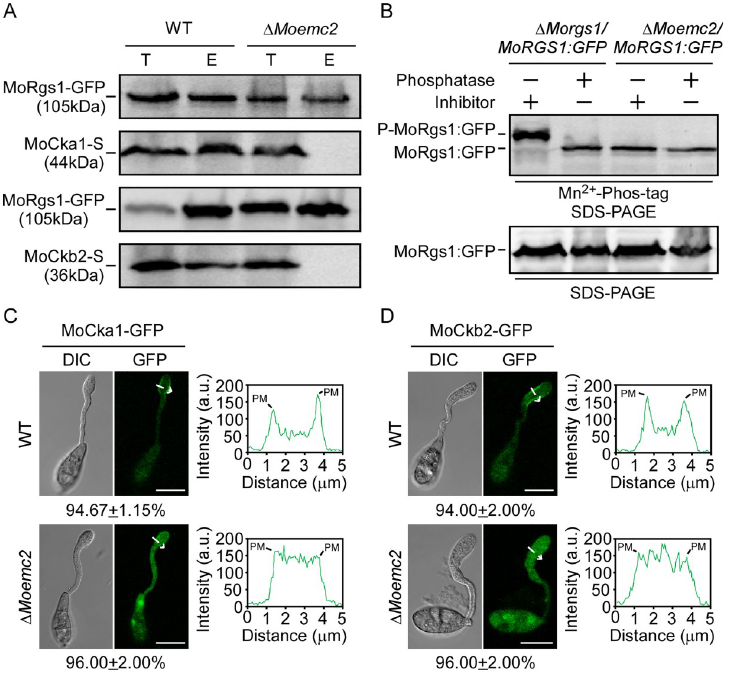
Fig 4. MoEmc2 is required for MoCk2 function and proper subcellular localization. (A) Co-IP assays for interactions between MoRgs1-GFP and MoCka1-S and MoCkb2-S in the wild type (WT) and mutant Δ Moemc2 strains. Total proteins were extracted and eluted from the anti-GFP agarose beads before being analyzed by Western blot with corresponding antibodies. T: Total protein E: Elution. (B) Phosphorylation analysis of MoRgs1 in the WT and Δ Moemc2 strains in vivo by Mn 2+ -Phos-tag gel electrophoresis. MoRgs1-GFP fusion proteins treated with phosphatase and phosphatase inhibitors were detected by the GFP antibody and shifted by Mn 2+ -Phos-tag SDS-PAGE and normal SDS-PAGE, respectively. (C and D) Fluorescence RFP labeled MoCka1 and MoCkb2 fusion constructs were introduced into the WT and Δ Moemc2 strains, respectively. Transformants were observed and photographed by LSM (Zeiss LSM710 laser scanning microscope, 63 × oil, Bar = 10 μ m) at the germ tube hooking stage. Insets highlight areas analyzed by line-scan (length = 5 μ m). The percentage of a pattern showed in the image was calculated by observation for 50 germinated conidia that were randomly chosen. All experiments were conducted with three biological repetitions and three